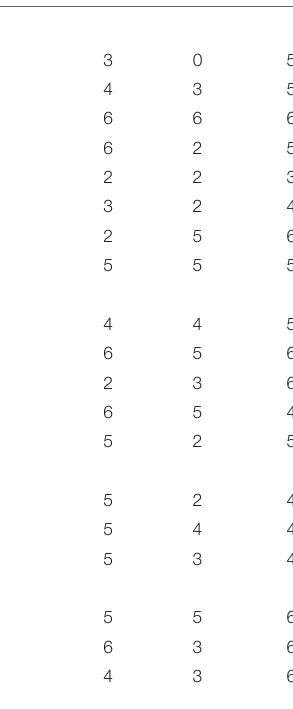
TABLE 2 | Perception of the PCSL ROs in Ethiopia, Uganda, and Kenya regarding the performance of the Participatory Adaptation Analysis as PAR during the Covid-19 pandemic from March 2020 until April 2021. Please rate the extent to which the statement applies to the Participatory Adaptation Analysis (PAA) in PCSL in your personal experience during the Covid-19 pandemic in 2020-2021. 1 = not applicable, 2 = applies to some extent, 3 = applies fairly well, 4 = applies very well, 5 = a major focus, 6 = this corresponds 100%. 0 means that no answer was given.